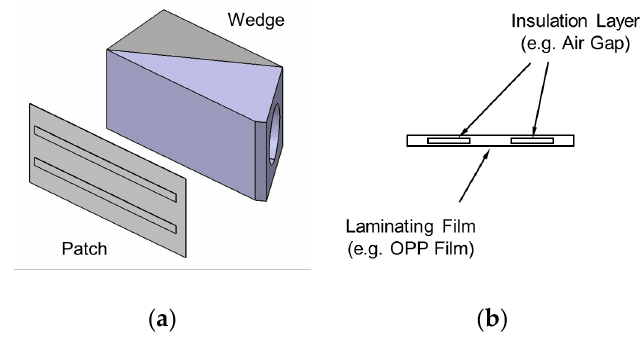
Figure 7. ( a ) Patch-based wedge and ( b ) cross section of the patch.